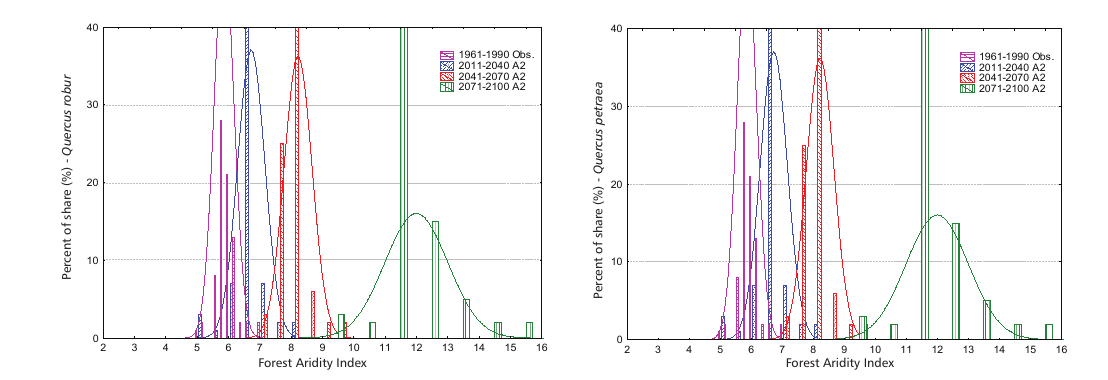
FIGURE 3. Distribution of Sessile oak across FAI categories in four climate periods